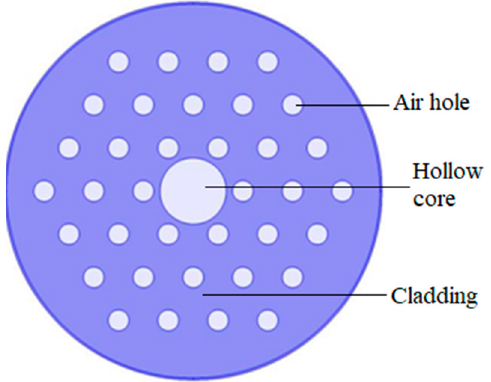
Figure 3. Diagram of hollow core PCF.